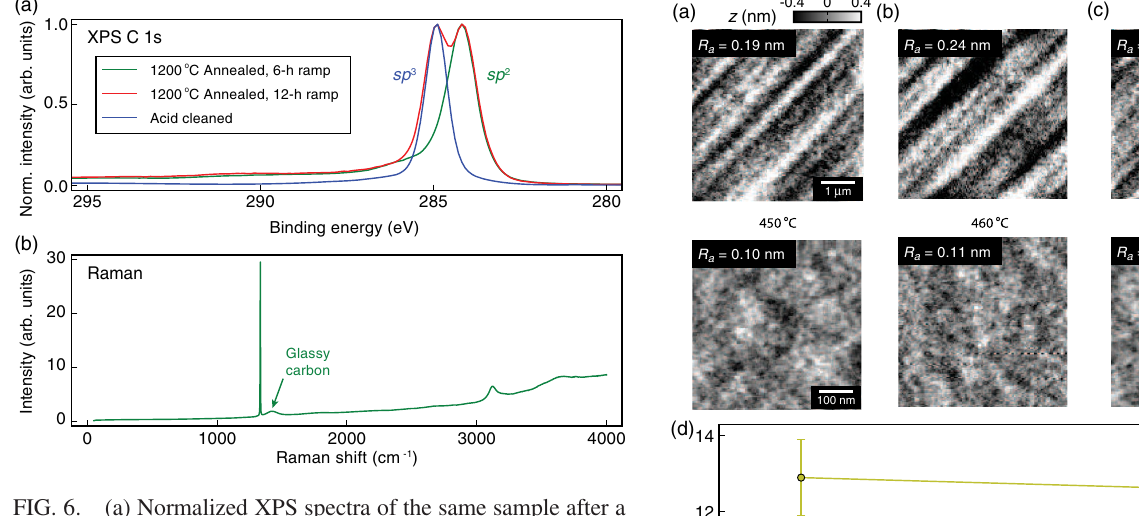
FIG. 6. (a) Normalized XPS spectra of the same sample after a 1200 °C anneal with different ramp rates. Material at the surface is converted to sp 2 carbon during annealing (red and green) and manifests as a peak at lower binding energy compared to the spectrum after the subsequent triacid clean (blue), which consists primarily of an sp 3 carbon peak. (b) The Raman spectrum of the 1200 °C annealed surface shows a glassy carbon peak, but no clear evidence of graphite peak at 1580 cm − 1